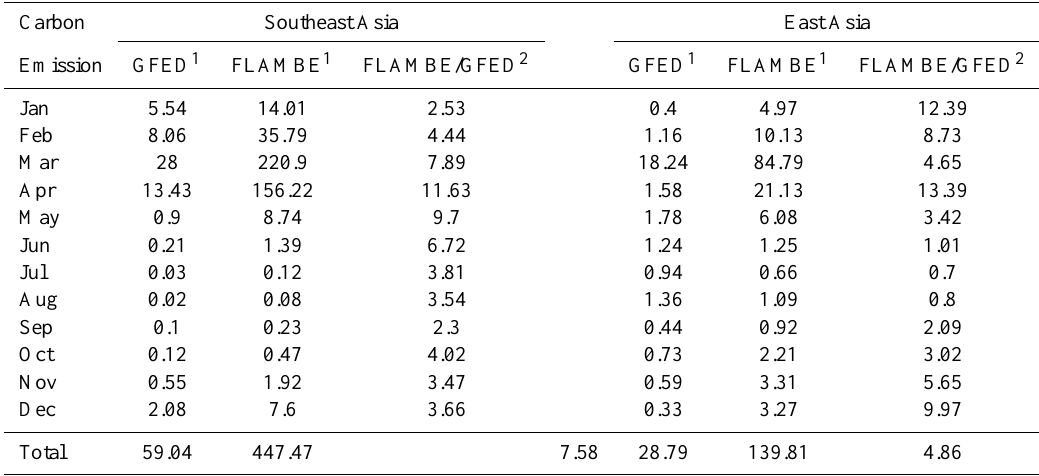
Table 2. The monthly carbon emission (Tg) from GFED and FLAMBE biomass burning emission inventories in both Southeast Asia and outside Southeast Asia in the domain (Referred as East Asia) in 2006, respectively.